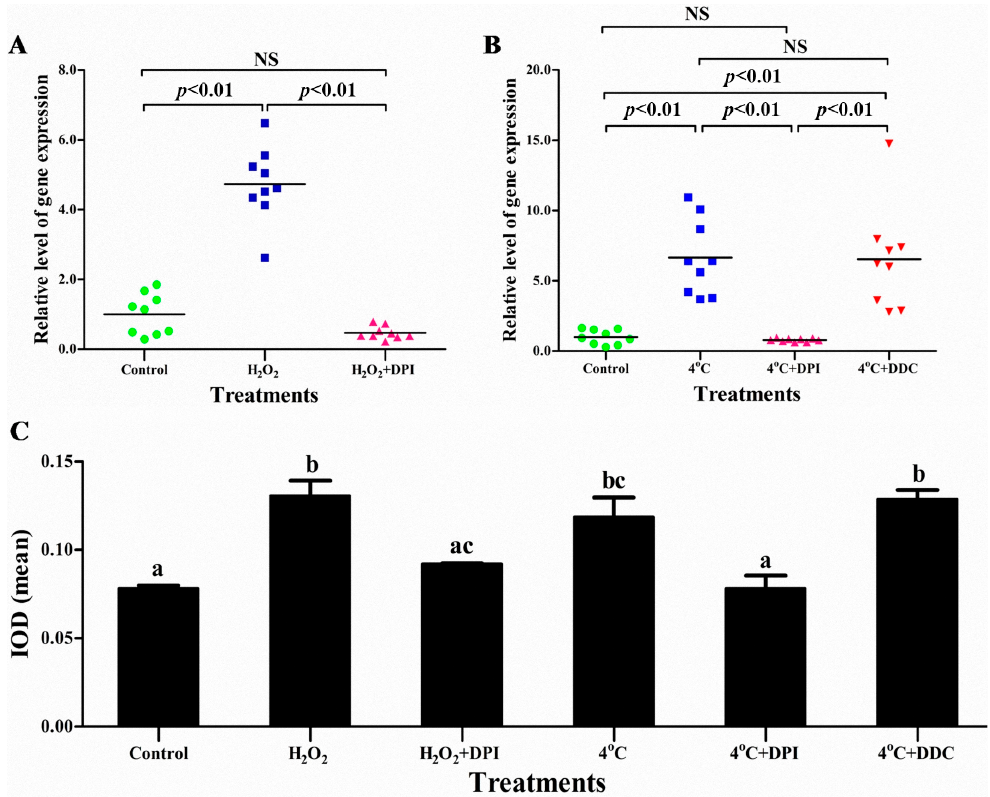
Figure 5. Relative expression levels of vvran1 and intracellular superoxide anion accumulation under abiotic stresses: ( A ) relative expression levels of vvran1 to hydrogen peroxide (H 2 O 2 ) stress; ( B ) relative expression levels of vvran1 to cold stress; and ( C ) the integrated optical density (IOD) mean of superoxide anion (O 2 − ) detection by nitroblue tetrazolium (NBT) straining. The control, hyphae were incubated in phosphate buffered solution (PBS) buffer for 1.5 h; the H 2 O 2 and H 2 O 2 + DPI treatment, hyphae were incubated in PBS buffer or PBS buffer with 50 µ mol/L DPI for 0.5 h, respectively, and then were switched to PBS buffer containing 10 mmol/L H 2 O 2 and incubated for 1 h; the 4 ◦ C and 4 ◦ C + DPI treatment, hyphae were incubated in PBS buffer or PBS buffer with 50 µ mol/L DPI for 0.5 h at 34 ◦ C, respectively, followed by replacing the warm PBS buffer with cold PBS buffer (4 ◦ C) and incubating the hyphae at 4 ◦ C for 1 h; and the 4 ◦ C + DDC treatment, hyphae were incubated for 0.5 h in PBS buffer at 34 ◦ C, followed by exchanging the warm PBS buffer with cold PBS buffer (4 ◦ C) containing DDC and incubating the hyphae at 4 ◦ C for 1 h. Relative expression levels of vvran1 in ( A , B ) were calculated relative to the transcript level of vvran1 in the control and three independent experiments with nine independent replicates are shown by different color of shapes. The values of IOD mean in ( C ) are the means ± standard deviation ( n = 3). Statistical testing of significance was performed using a one-way ANOVA and a Bonferroni’s posttest, NS means no significance, and the different letters over the columns within a graph denote significant differences ( p < 0.05).